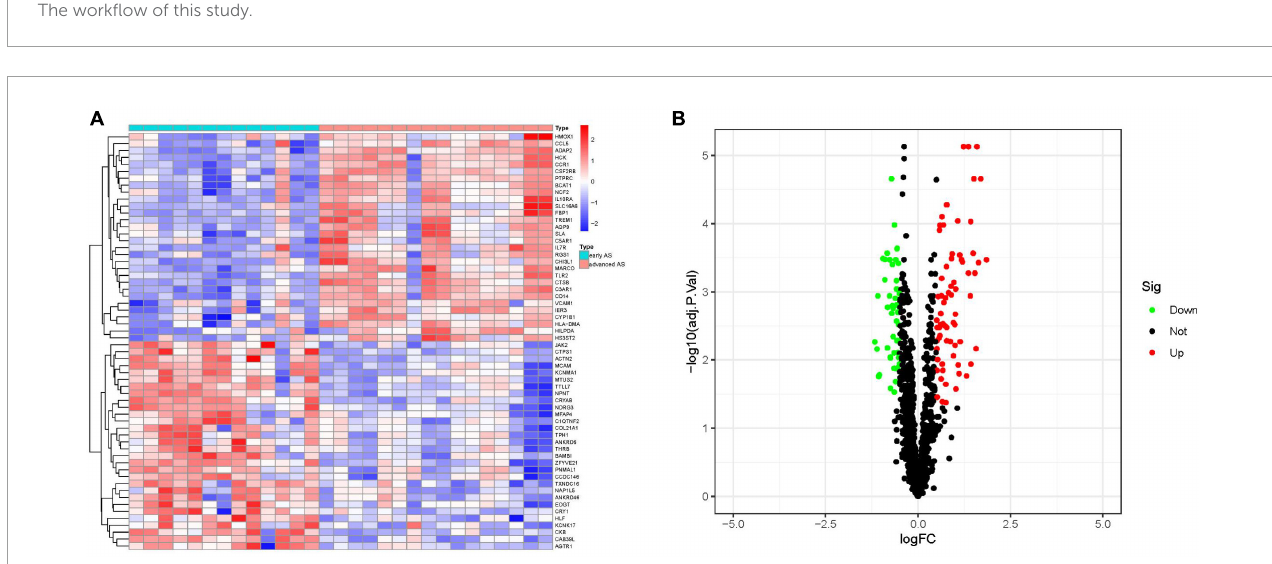
FIGURE2 Analysis of differential genes. (A) Heat map of differential genes. (B) Volcano map of differential genes. (S1 represents early AS, S2 represents advanced